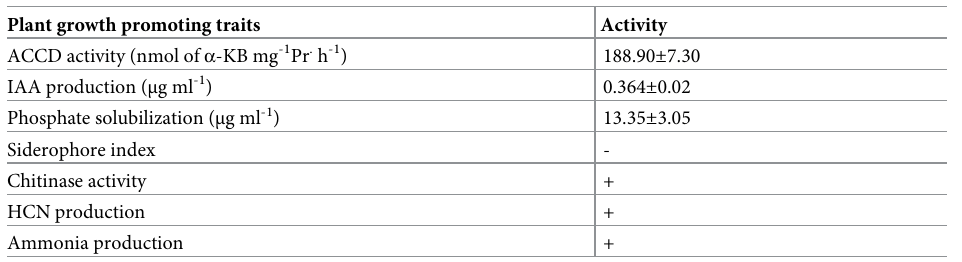
Table 1. Plant growth promoting traits of